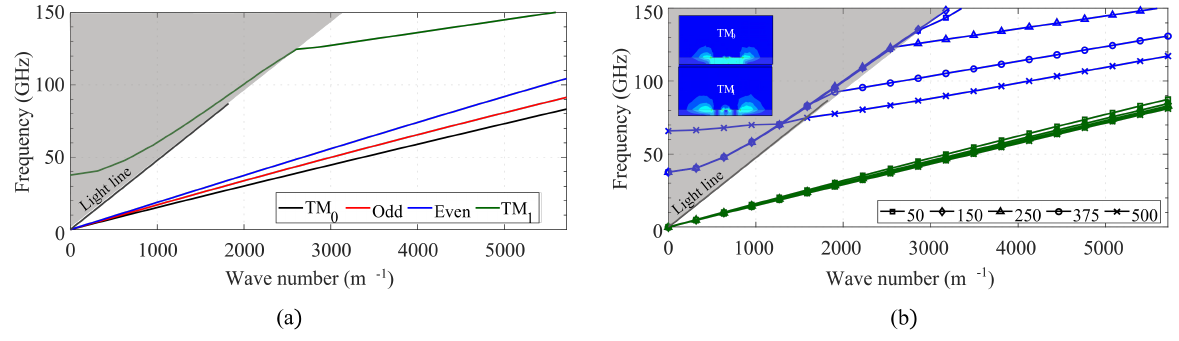
Figure 6. Dispersion curves in a CB-CPW on 100 µ m silicon substrate. ( a ) First 4 modes where lateral ground extension is 250 µ m. ( b ) Substrate modes (TM 0 —green, TM 1 —blue) for different lateral ground extensions (in µ m). Insets: E-field magnitude of the corresponding modes.